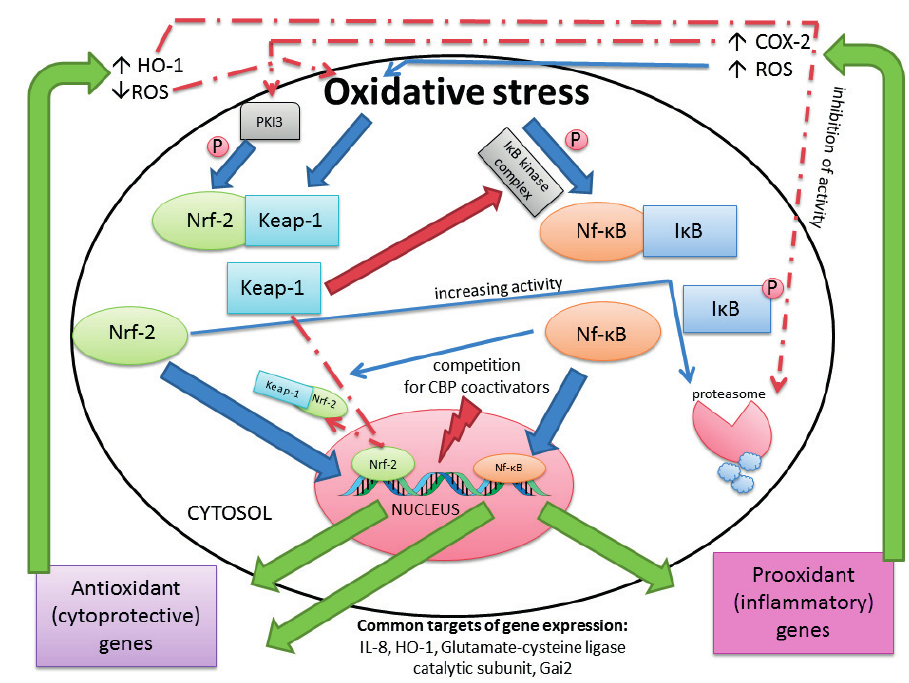
Fig. 4. The relationship between Nrf2 and